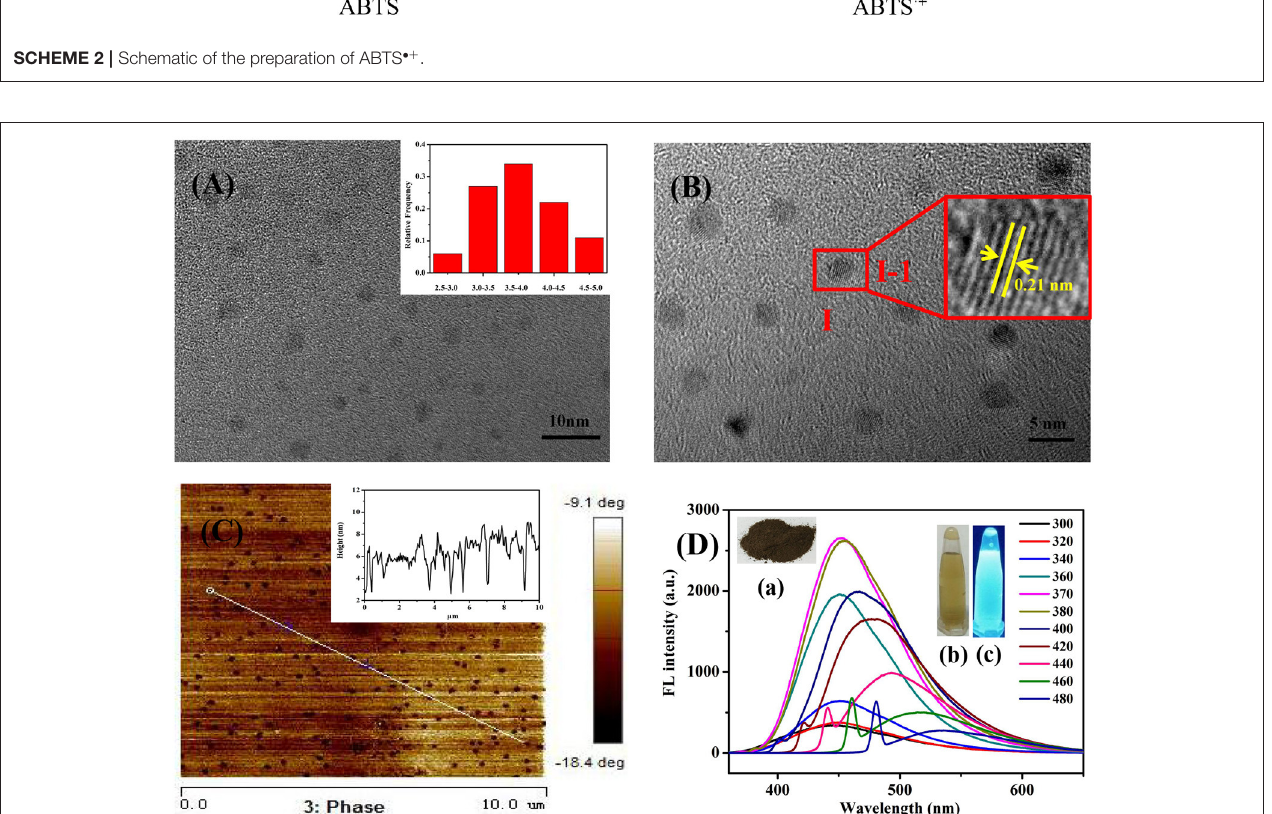
Figure 1 | (A) TEM image of Se/N-CQDs. Insert: Diameter distribution histogram of Se/N-CQDs. (B) HRTEM image of Se/N-CQDs. Insert: (I-1) Magnified image of “I” Se-CQD. (C) AFM image of Se/N-CQDs. Insert: AFM height profile analysis along the corresponding line in (C) . (D) Emission spectra of Se/N-CQDs at different excitation wavelengths. Inserts: (a) The powder photograph of Se/N-CQDs; (b) the photographs of Se/N-CQDs solutions under the white light irradiation; (c) the photographs of the preparation of Se/N-CQDs solutions under the UV (365nm) light